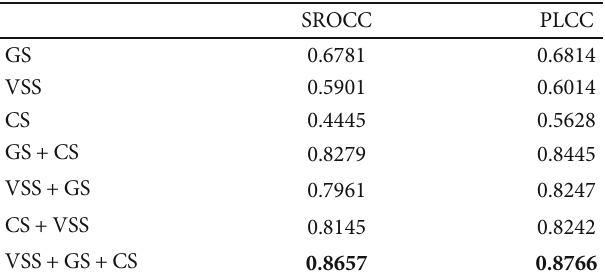
Figure 4: The histogram of the mean values of SROCC results for AWGN, JPEG, JP2K, and GB distortion types of 8 IQM models in LIVE, CSIQ, and TID2013 databases. Table 4: Ablation experiments about the di ff erent similarity